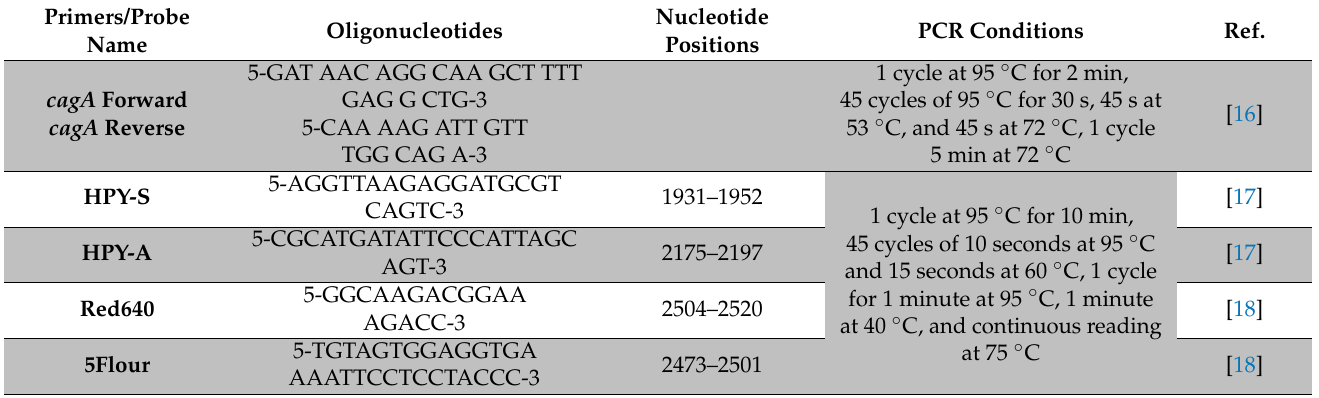
Table 1. The hybridization probes and primers used for the detection of the cagA gene and A2143G, A2142C, and A2142G